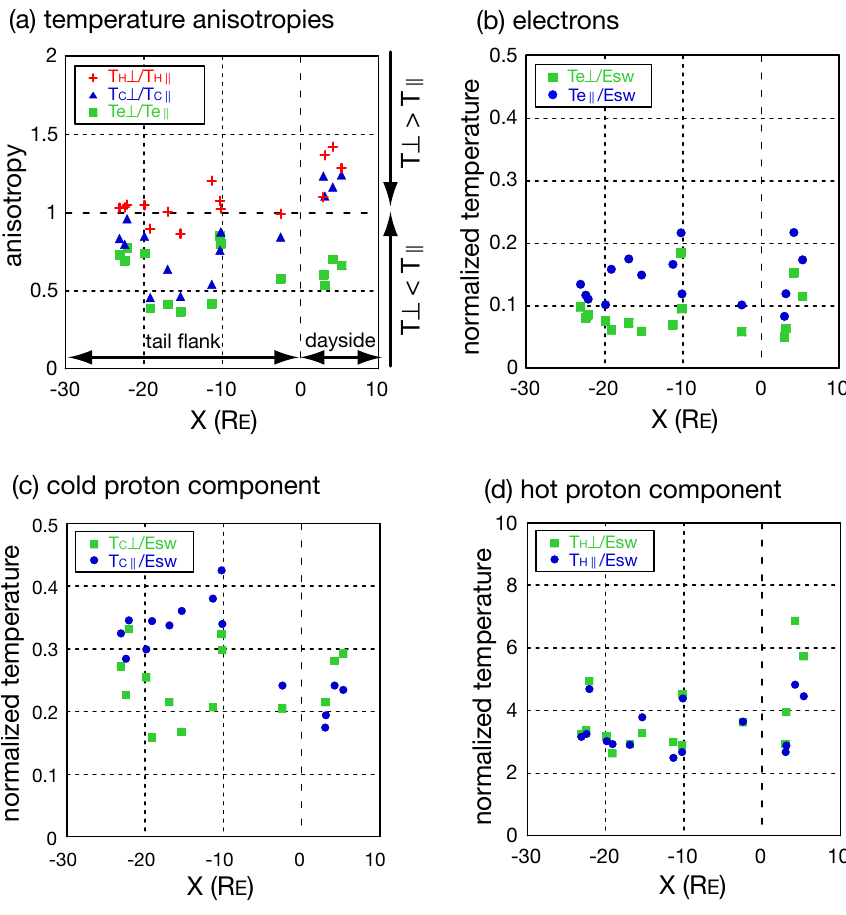
Fig. 9. Statistical plots for the 4 dayside and 11 tail events. Panel (a) shows anisotropies (i.e. ratios of perpendicular to parallel temperature) of the cold protons, the hot protons, and the electrons. The blue (red) points correspond to the ratio of the cold (hot) component temperatures, and the green squares represent the electron temperatures. Panels (b–d) show the relation between the X coordinate of the observed locations and the temperatures normalized by the kinetic energy by the solar wind protons (437.7km/s = 1keV). Panel (b) shows the normalized temperatures of electrons in the perpendicular and parallel direction to the magnetic field, with green squares (blue circles) corresponding to the perpendicular (parallel) temperature. Panels (c) and (d) present the normalized temperatures of the cold and hot proton components,